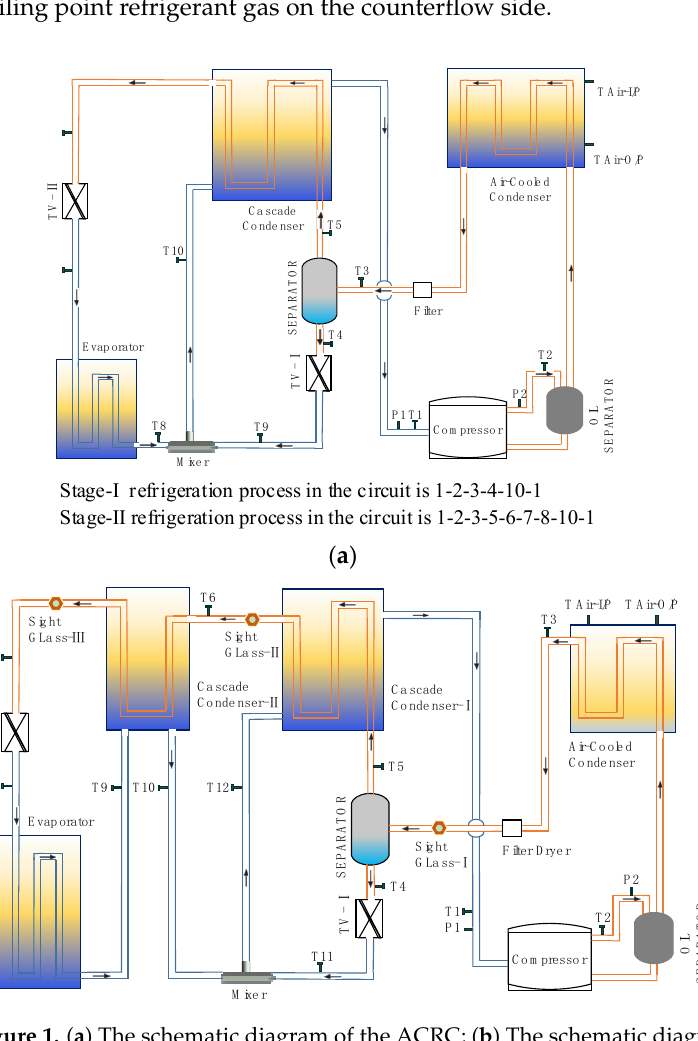
much higher dryness (point 10). The low-pressure refrigerants vapor that flows out of the second cascade condenser joins the two-phase refrigerants that flow out of the TV-I (point 12). The combined mass fluid enters the low-pressure section of the first cascade condenser to evaporate to a higher dryness (point 1). In this process, it provides cooling to the low boiling point refrigerant gas on the counterflow side.